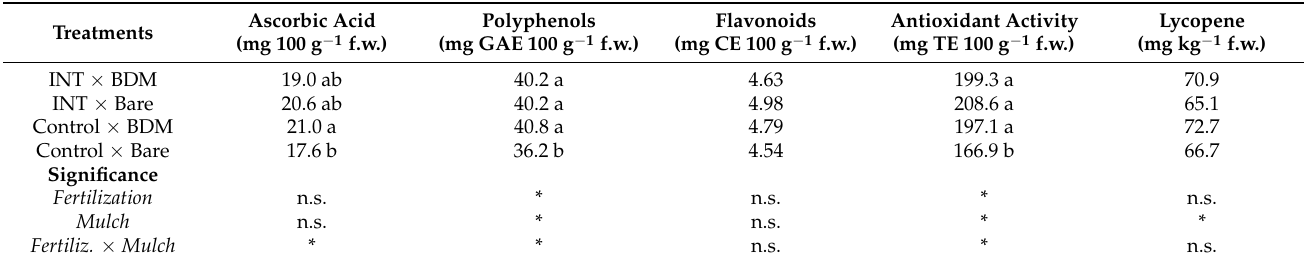
Table 7. Antioxidant compounds and antioxidant activity in tomato cv Heinz 5588, as influenced by the interaction of Fertilization and mulch in 2017.